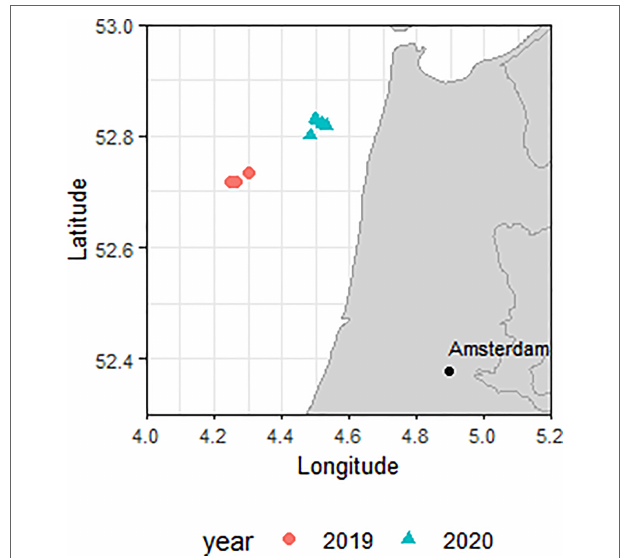
FIGURE 2 | Locations of the Experiment 1 (2019, red dots) and Experiment 2 (2020, blue triangles) tows.